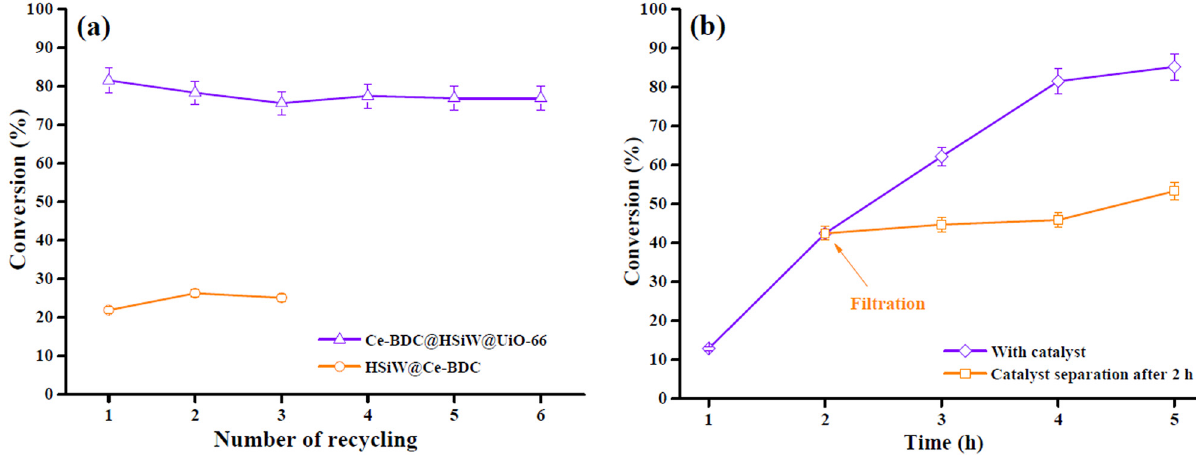
Figure 9: Recycling ( a ) and leaching ( b ) test results for Ce - BDC@HSiW@UiO - 66